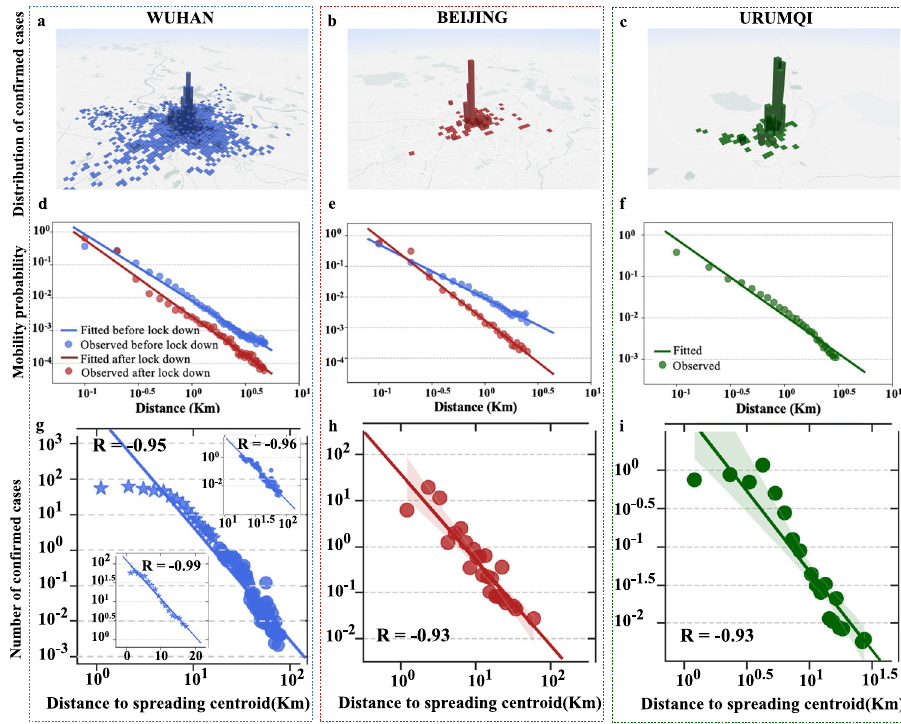
Fig. 2 The spatial spreading pattern of COVID-19 in Wuhan, Beijing, and Urumqi. a – c A visualization of the number of con fi rmed cases in discretized grids in Wuhan, Beijing, and Urumqi, respectively. d – f The human mobility distribution (dots) as a function of traveling distance and the fi tted models (lines) for Wuhan, Beijing, and Urumqi, respectively. g – i The spatial distributions (dots) as a function of distance from the overall spreading centroid and the fi tted regression lines for these